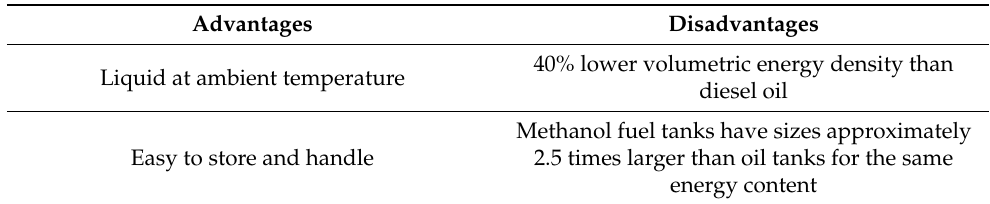
Table 6. An overview of the advantages and disadvantages of methanol as an alternative fuel for the shipping sector